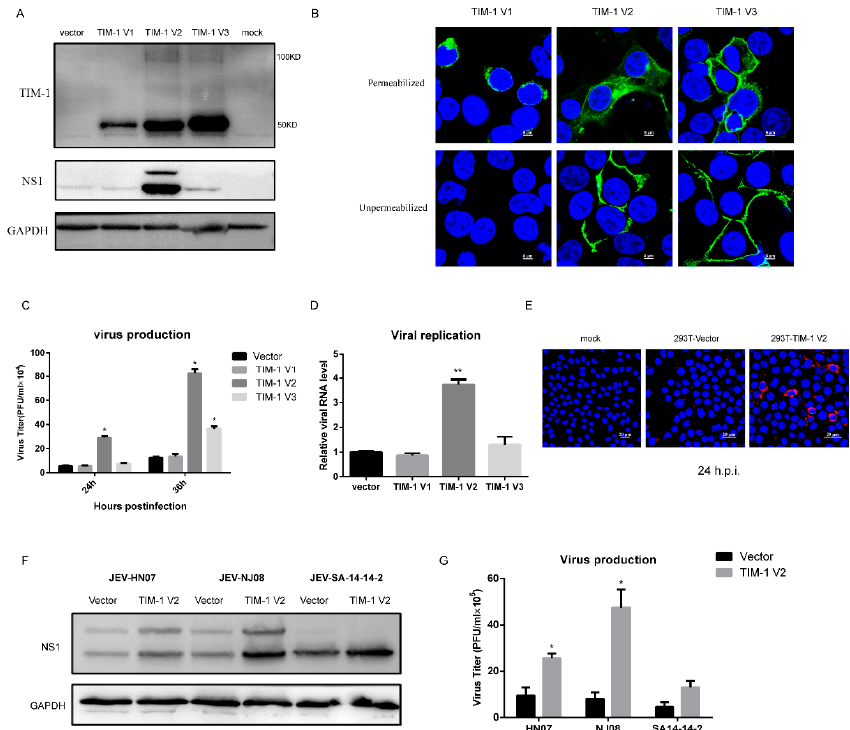
Figure 3. Polymorphisms of TIM-1 are associated with JEV susceptibility to host cells. 293T cells were transfected with an empty vector and plasmids encoding three TIM-1 variants for 24 h. ( A ) Cells were challenged with JEV NJ2008 (MOI of 1), and cell lysates were harvest at 24 h.p.i. JEV NS1 protein and TIM-1 expression were determined by Western blot analysis using a specific monoclonal antibody. One representative experiment out of three is shown; ( B ) cells were fixed and detected by confocal microscopy under permeabilized and unpermeabilized condition. Scale bars, 5 µ m; ( C ) supernatants were collected at 24 h.p.i. and 36 h.p.i. and the production of progeny virions was determined by a plaque assay titered on BHK-21 cells. Data are presented as mean ± SD from three independent experiments using t-test. * p < 0.05; ( D ) cells were transfected with indicated plasmids for 24 h and infected with JEV NJ2008 (MOI of 1). Total RNA was extracted and viral replication was detected by qRT-PCR at 24 h.p.i. Data are presented as mean ± SD from three independent experiments using t -test. ** p < 0.01; ( E ) 293T cells were transfected with indicated plasmids for 24 h. Cells were incubated with JEV (MOI = 1) for 24 h. Then they were fixed and stained with anti-E monoclonal antibody. Scale bars, 20 µ m. 293T cells transfected with a plasmid encoding TIM-1 V2 or an empty vector were infected with different strains of JEV (HN07, NJ2008, and SA14-14-2) at a 0.5 MOI; ( F ) cell lysates were harvested at 40 h.p.i. and JEV infection was determined by the level of NS1 protein using Western blot analysis. One representative experiment out of three is shown; ( G ) supernatants were collected and the production of JEV virions were determined by a plaque assay titrated on BHK-21